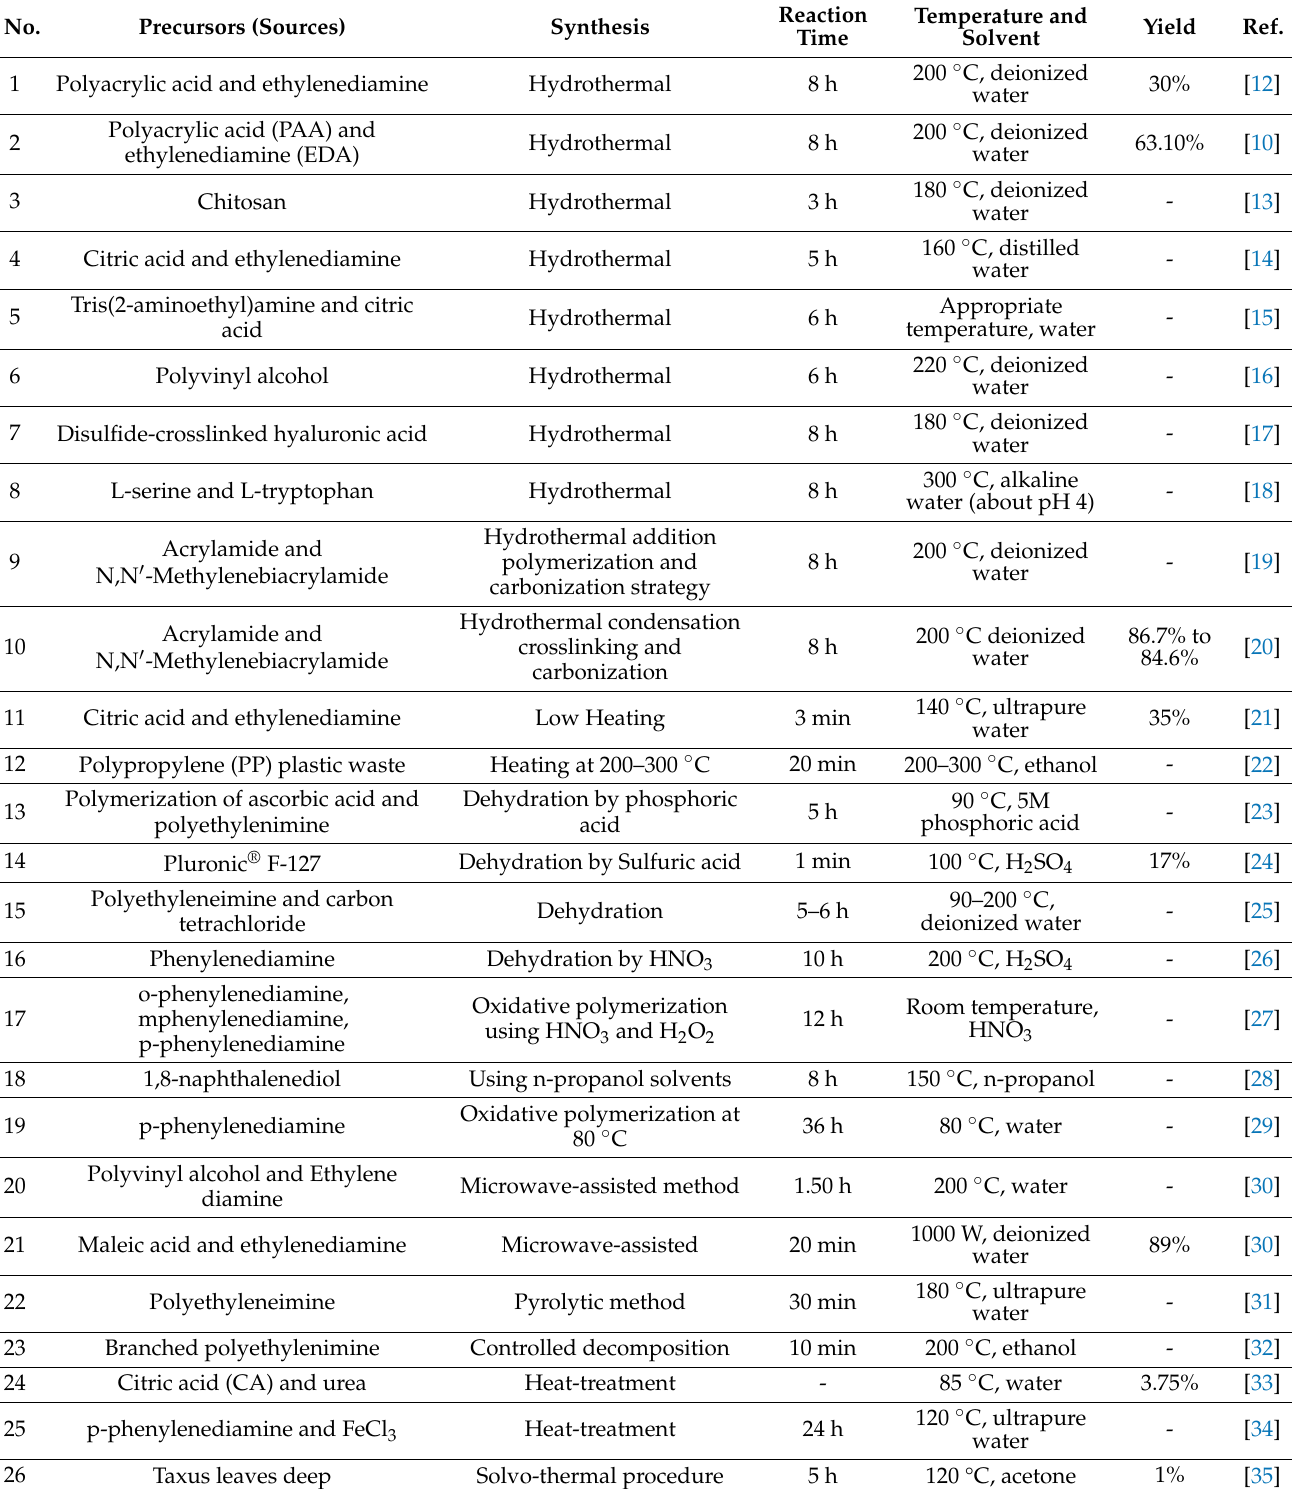
Table 1. The representative examples of Carbon Polymer Dots (CPDs) and their synthesis conditions including, reaction time, temperature, solvent and reaction